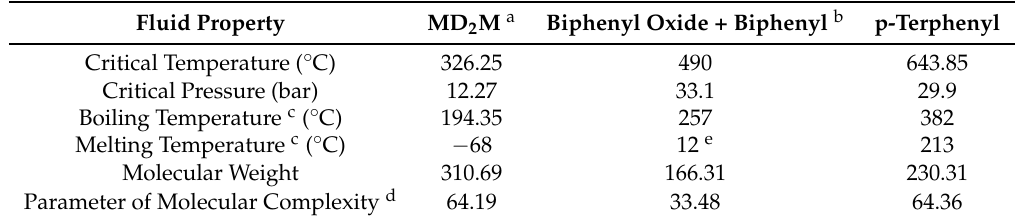
Table 1. Some properties of the considered working fluids.